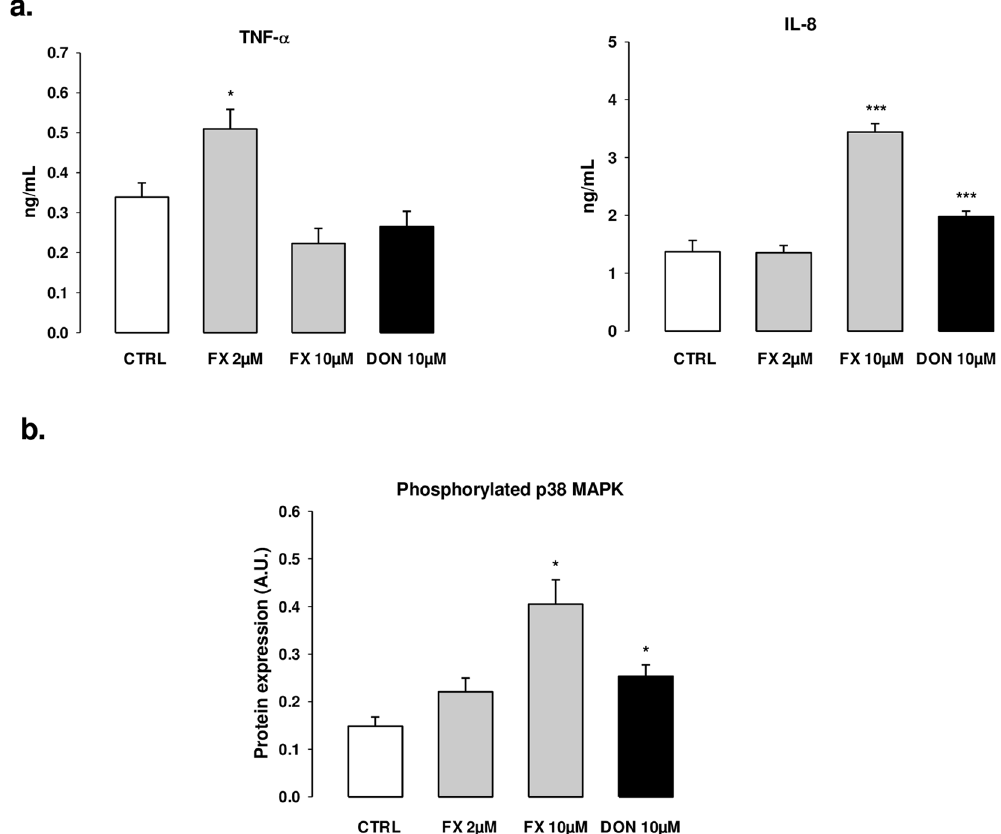
Figure 4. Intestinal inflammation is the hallmark of the molecular toxicity of DON and FX. IPEC-J2 cells differentiated on inserts were cultured in presence of 2 or 10 µ M of FX, or 10 µ M of DON, or DMSO for 24 h or 48 h. (Panel a) TNF and IL-8 production in the cell culture supernatants were quantified by ELISA. (Panel b) Cell lysates were analyzed by western blot for expression of phosphorylated p38 MAPK, using β -actin as a protein loading control. The normalized expression data are presented. The results for ELISA and western blot are expressed as mean ± SEM of 3 independent experiments, * p < 0.05, ** p < 0.01, *** p <